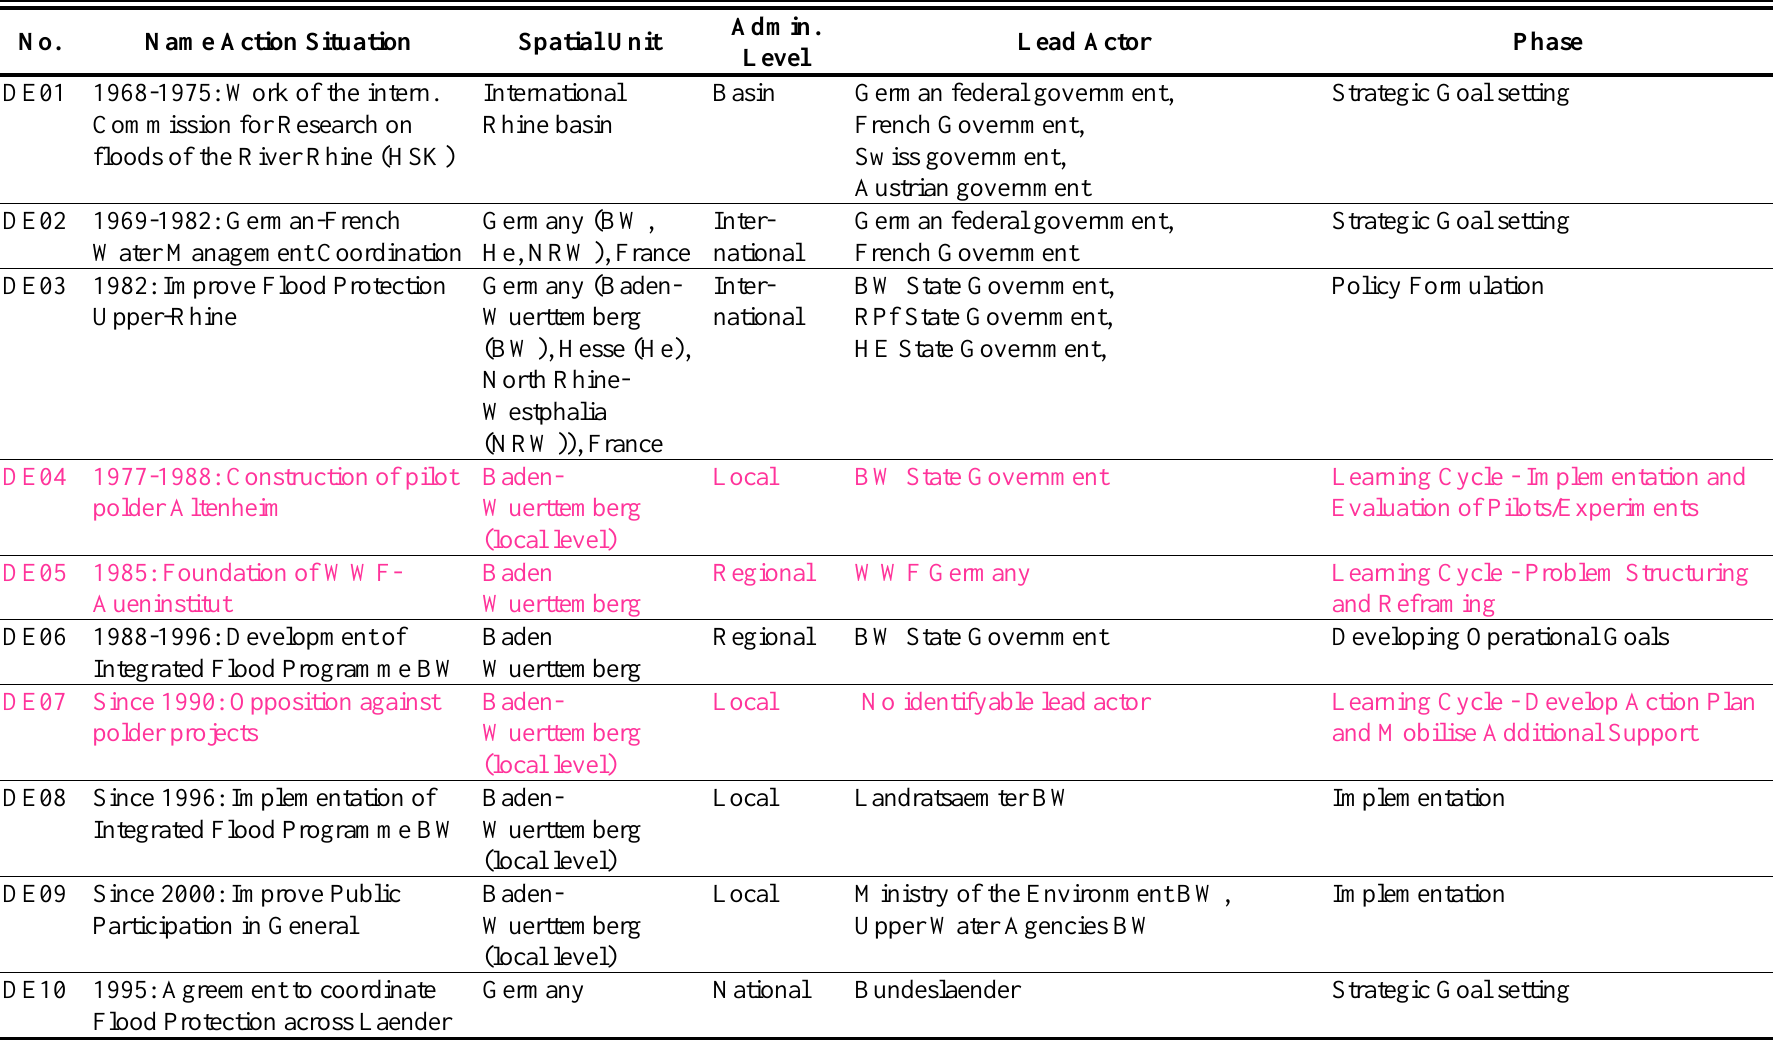
Table A4. Action Situations for the Rhine Germany (DE, learning ASs in pink).